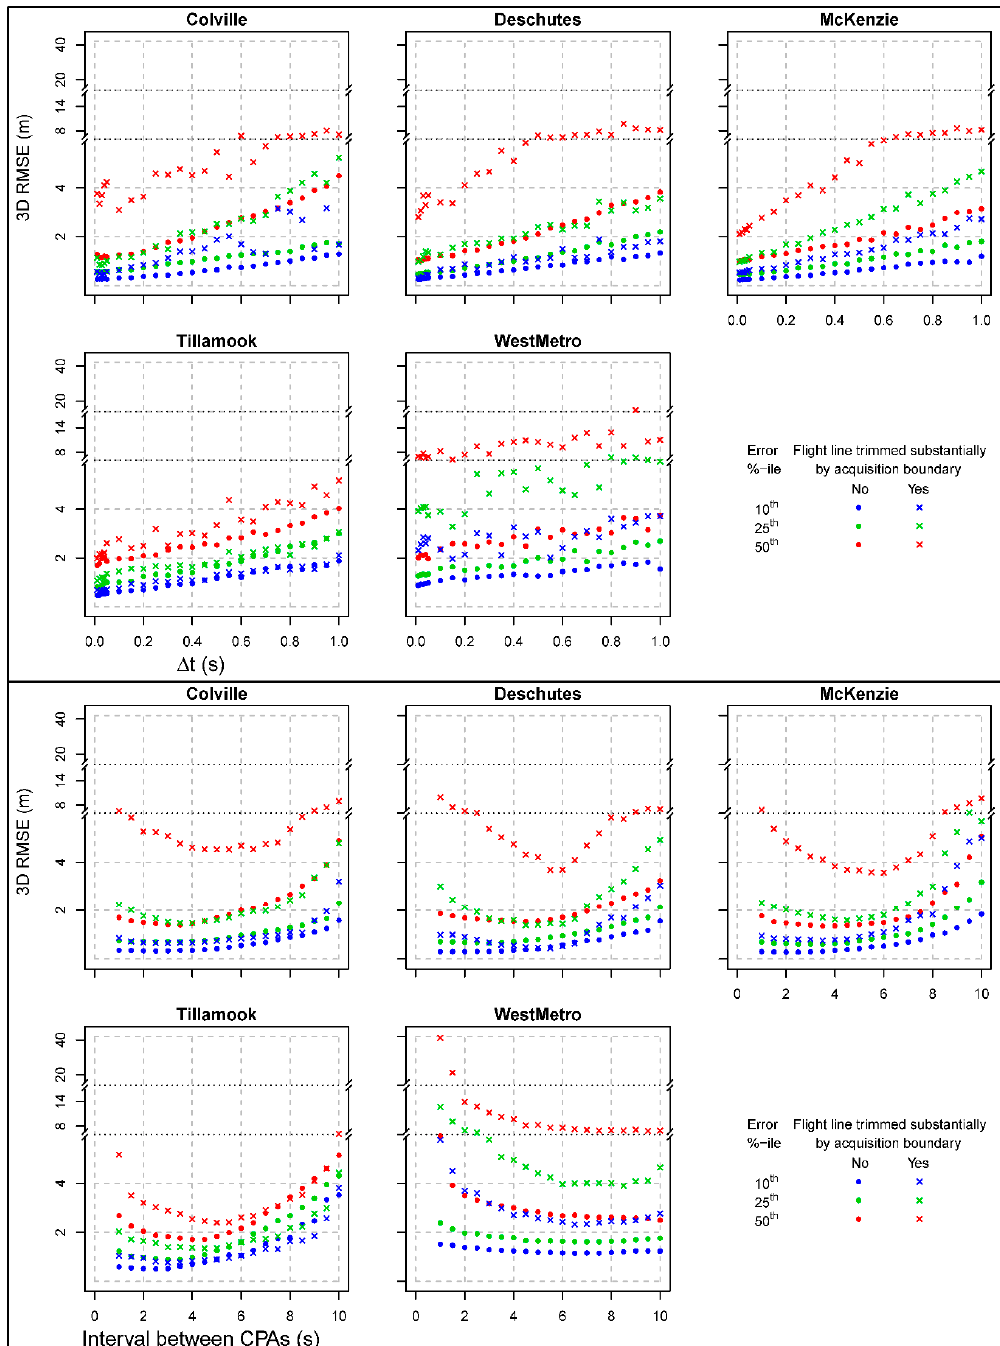
Figure A2. Distribution of error percentiles in splines fit to flight line-specific CPA sets across study areas as function of time block duration (top) and time intervals between CPAs used in the fitting (bottom), calculated using recorded platform positions. Dots/Xs pertain to CPA sets from scan swaths free of/affected by substantial trimming with acquisition boundaries respectfully. Note scale discontinuities along the Y axes.